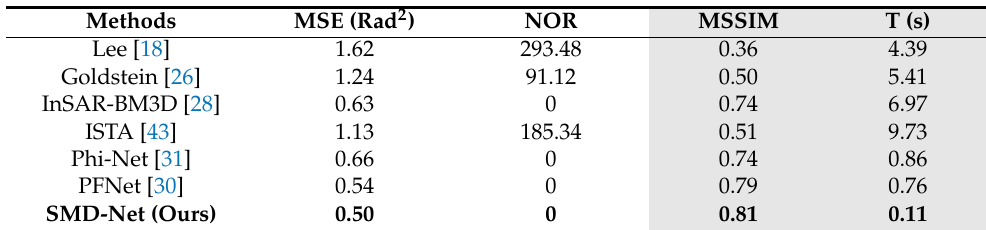
Figure 7. The analysis of the simulated interferogram patch: ( a1 – g1 ) Filtered interferograms of the Lee filter, Goldstein filter, InSAR-BM3D filter, ISTA, Phi-Net, PFNet, and the proposed method; ( a2 – g2 ) difference images of Figure 6a and ( a1 – g1 ) in sequence; ( a3 – g3 ) SSIM maps of Figure 6a and ( a1 – g1 ), respectively. Table 1. The metrics of the seven methods on the simulated interferogram. MSSIM is the core accuracy index. T is the speed